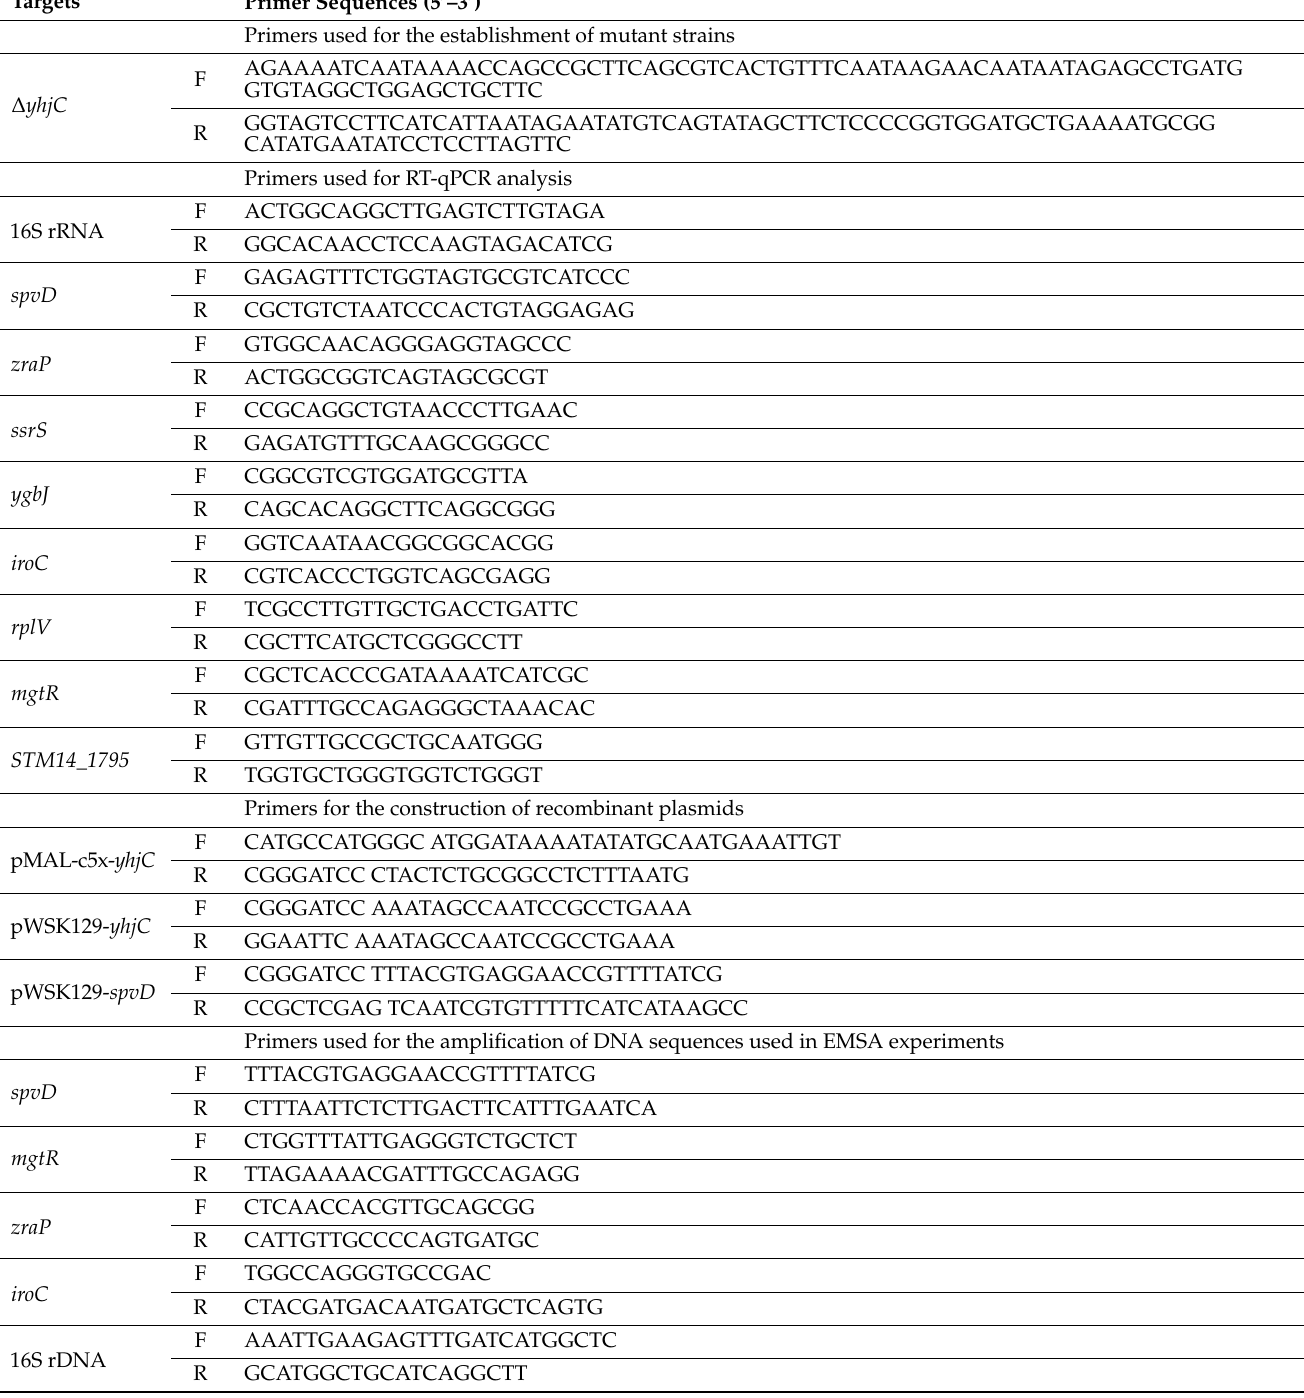
Table 2. Primers involved in this